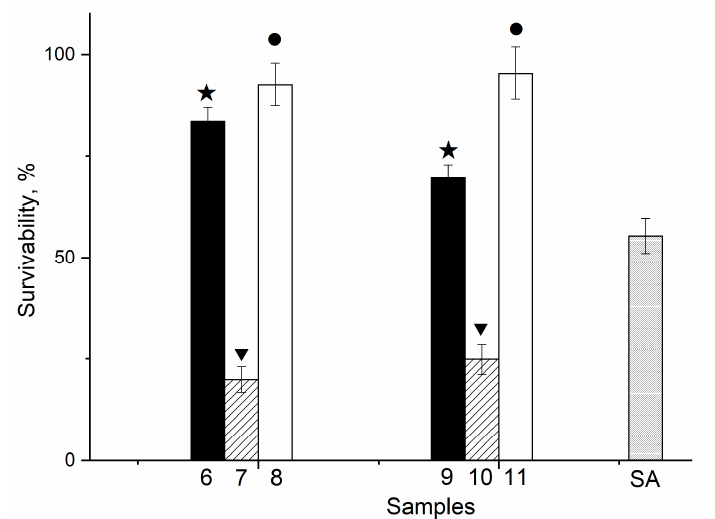
Figure 13. The number of DPSC cultured on the film surface of samples 6 − 11 (Table 1). Control sample (glass slide) corresponds to 100%. The stars correspond to PVP-SA blends, the triangles—to composites PVP-SA-HA in situ, the circles—to composites PVP-SA-HA ex situ. The statistical analysis of the reliability was performed according to the Mann–Whitney U-test ( p ≤ 0.01).